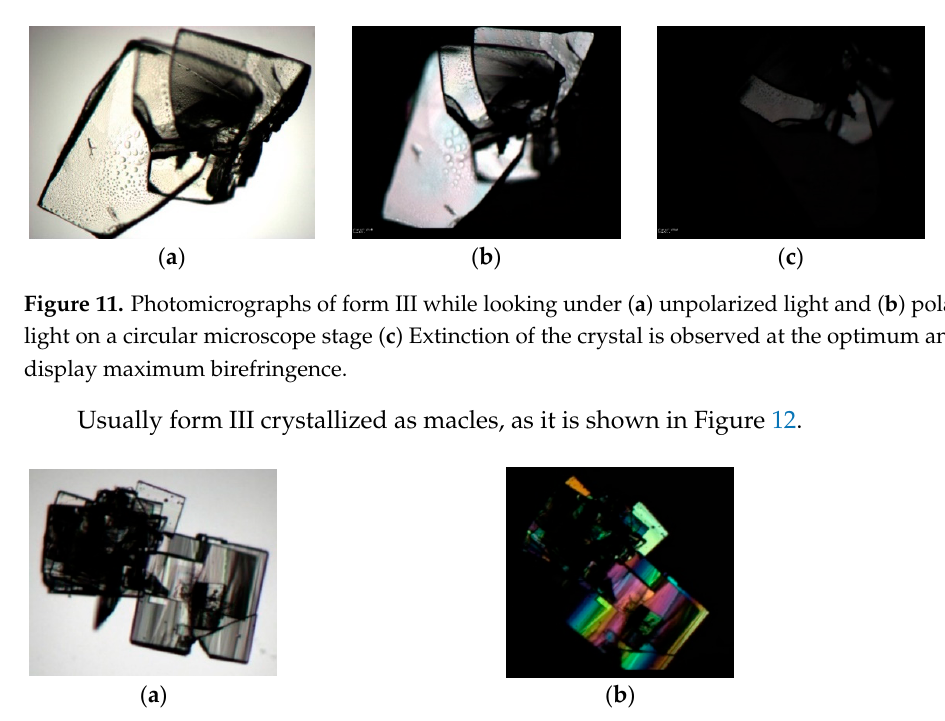
Figure 12. Photomicrographs of macles of form III observed under (a) unpolarized light and (b) polarized light microscope.